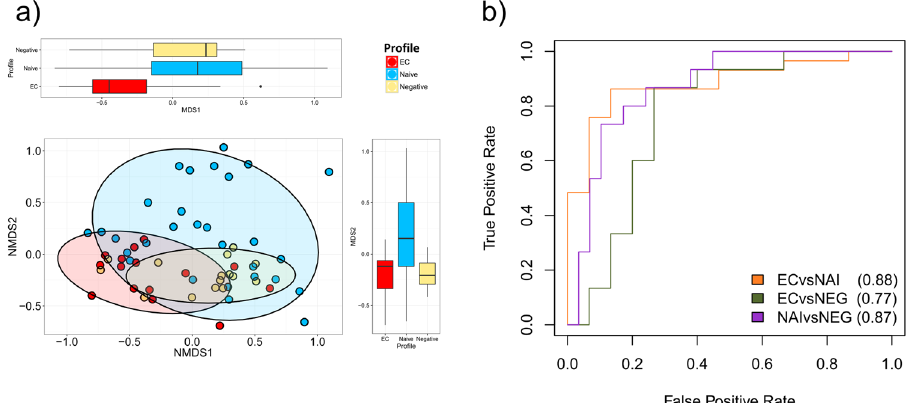
Figure 2. Separation between EC and naive patients in inter-individual (ß-diversity) analyses. Non-metric multidimensional scaling (NMDS) analysis was performed to characterize inter-individual differences between groups, revealing clustering of EC at NMDS axis 1 and naive at axis 2. The separations between groups at each axis are presented in respective box-plot. Box plots represent median (black horizontal line), 25th and 75th quartiles (edge of boxes), upper and lower extremes (whiskers). Outliers are represented by a single data point ( a ). LASSO regression analysis with AUROC (ROC curves; AUC used for estimation of model accuracy) curve was used for classification of gut microbiota composition between groups, and lowest accuracy was found between EC and negative patients (AUC 0.77, suggesting that the similarity of microbiota composition was highest between these groups) ( b